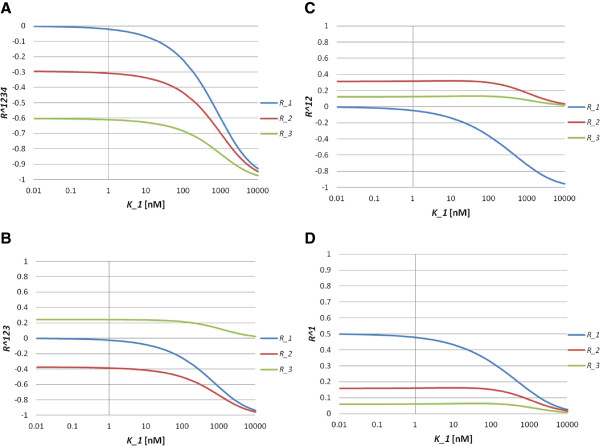
Behaviours of the response coefficients for Model S4. (A) Response coefficient Ri1234 (i = 1,2,3) as a function of K1. Blue, red and green lines indicate R11234, R21234 and R31234, respectively. (B) Response coefficient Ri123(i = 1, 2, 3) as a function of K1. Blue, red and green lines indicate R1123, R2123 and R3123, respectively. (C) Response coefficient Ri12(i = 1, 2, 3) as a function of K1. Blue, red and green lines indicate R112, R212 and R312, respectively. (D) Response coefficient Ri1(i = 1, 2, 3) as a function of K1. Blue, red and green lines indicate R11, R21 and R31, respectively. For all, we set K2 = K3 = 100nM.